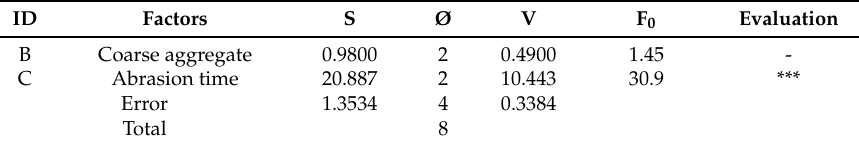
Table 9. Variance analysis for the solid volume of recycled fine aggregate after